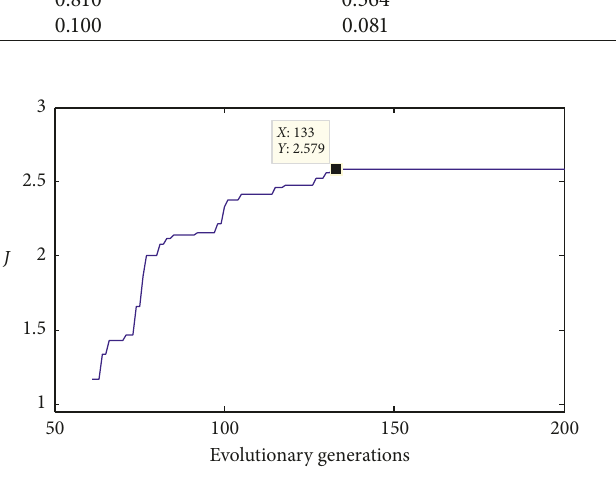
Figure 7: The curve of fitness value. Table 2: Result of the optimal control